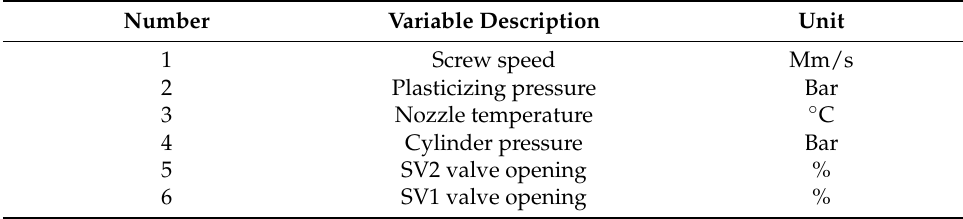
Table 1. Process variables of injection molding process in start-up process.